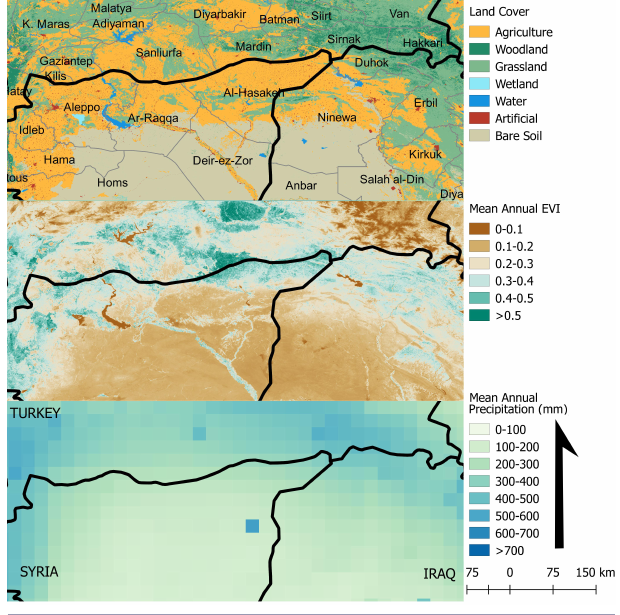
Fig. 1. Study area map showing the different provinces included in the analysis. Land cover data for 2010 come from Globeland30, provided by National Geomatics Center of China. Furthermore, the Mean Annual EVI (MODIS) and the Mean Annual Precipitation (TRMM) are